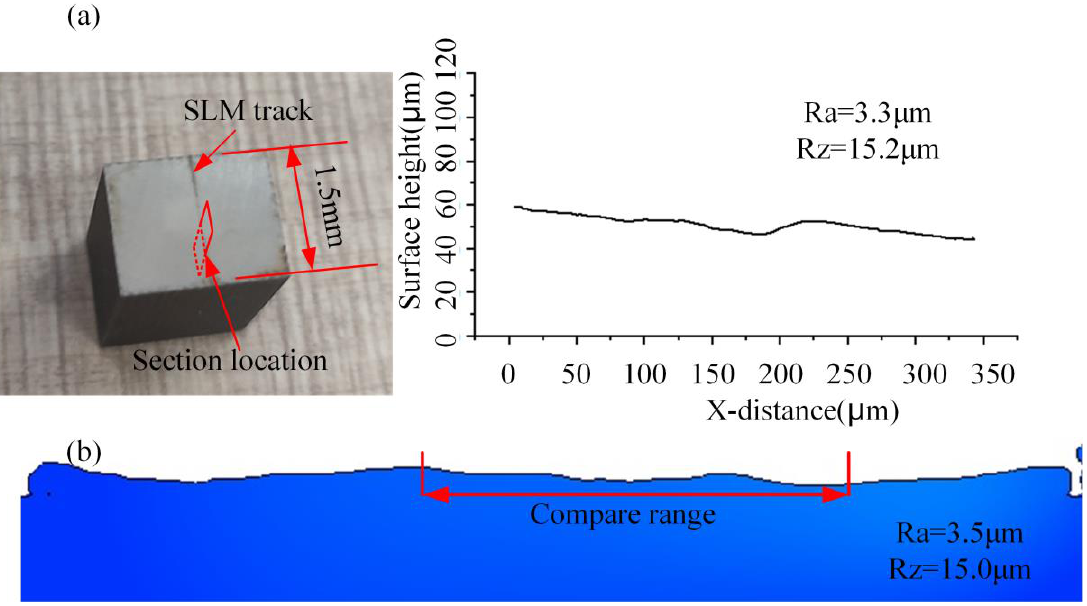
Figure 6. Simulation and experimental surface comparison. ( a ) experiment; ( b ) simulation. Obtained at 185 W, 0.6 m/s and spot diameter were 0.05 mm (power, speed and spot